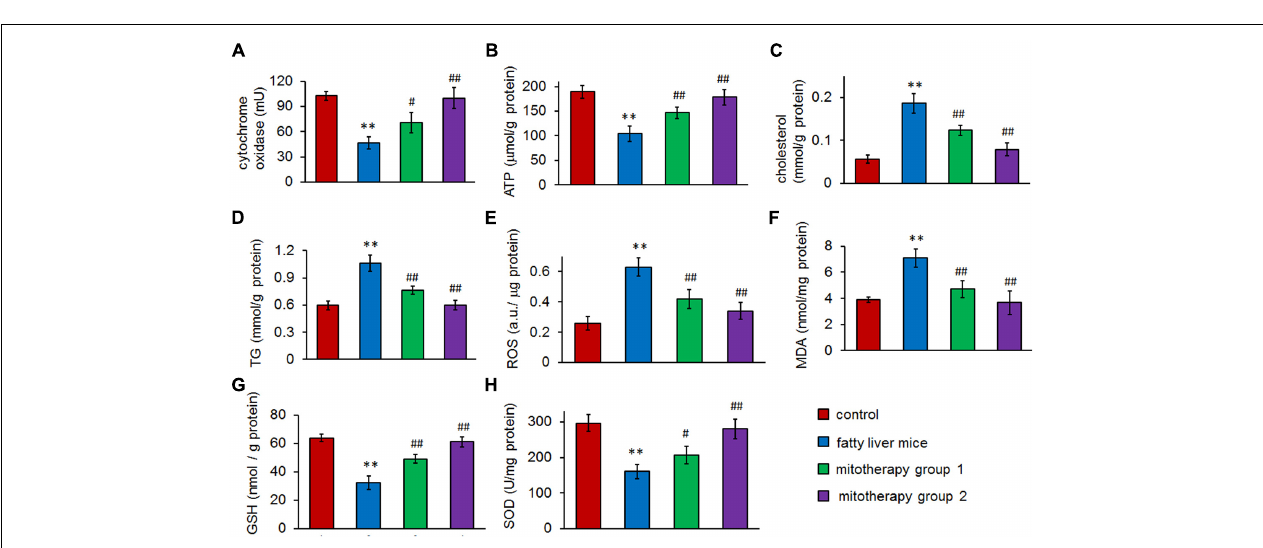
FIGURE 5 | Therapeutic effects of mitochondria on high-fat diet-induced fatty liver. (A) Mitochondrial cytochrome oxidase activity. (B) ATP content. (C) Hepatic cholesterol. (D) Hepatic TG. (E) ROS content. (F) MDA level. (G) GSH level. (H) SOD activity. Data were expressed as mean ± SEM ( n = 10 mice for each group). ∗∗ p < 0.01 compared with the control; # p < 0.05, ## p < 0.01 compared with the fatty liver